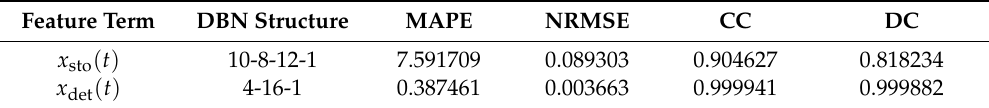
Table 1. DBN structure and the forecasting result of training